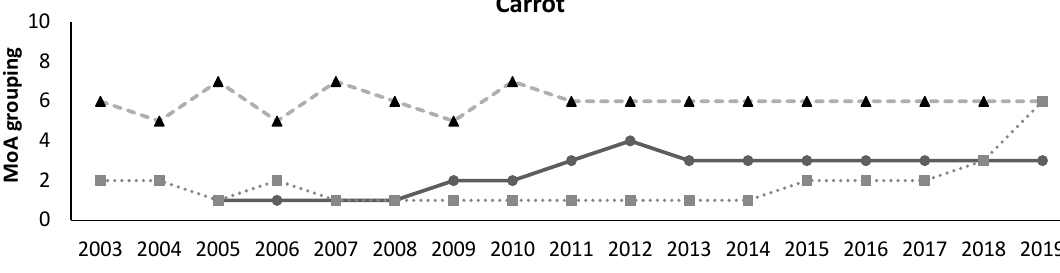
Fig. 4. The number of different MoA groups for fungicides, herbicides, and insecticides used on carrot in 2003–2019 Figure